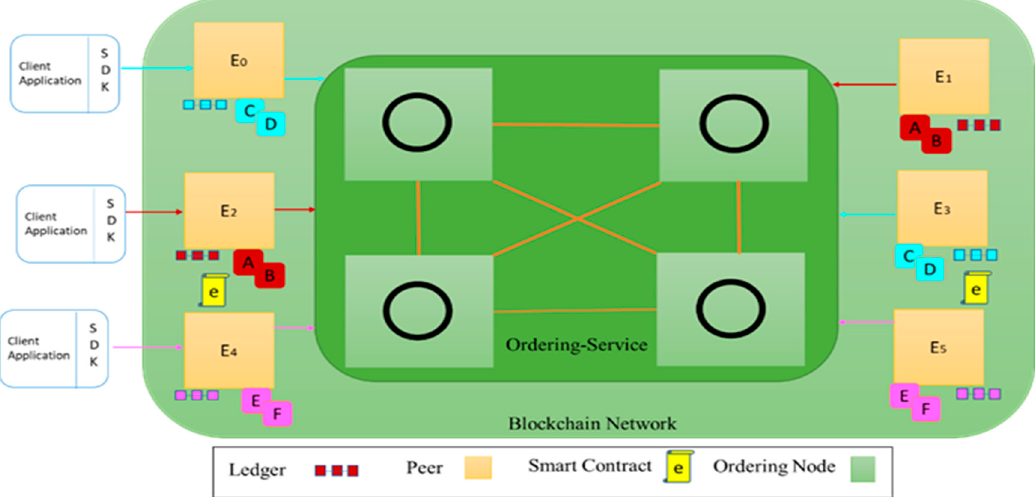
Figure 7. Developed blockchain network: three clients and 6 edge nodes. Implementation of Proof of the Delivery and Smart Contract